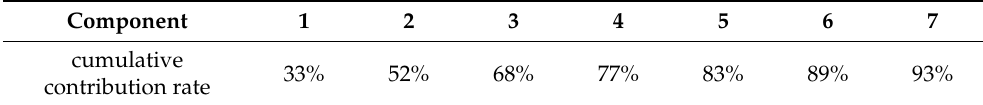
Table 2. Cumulative contribution rate of the principal components.